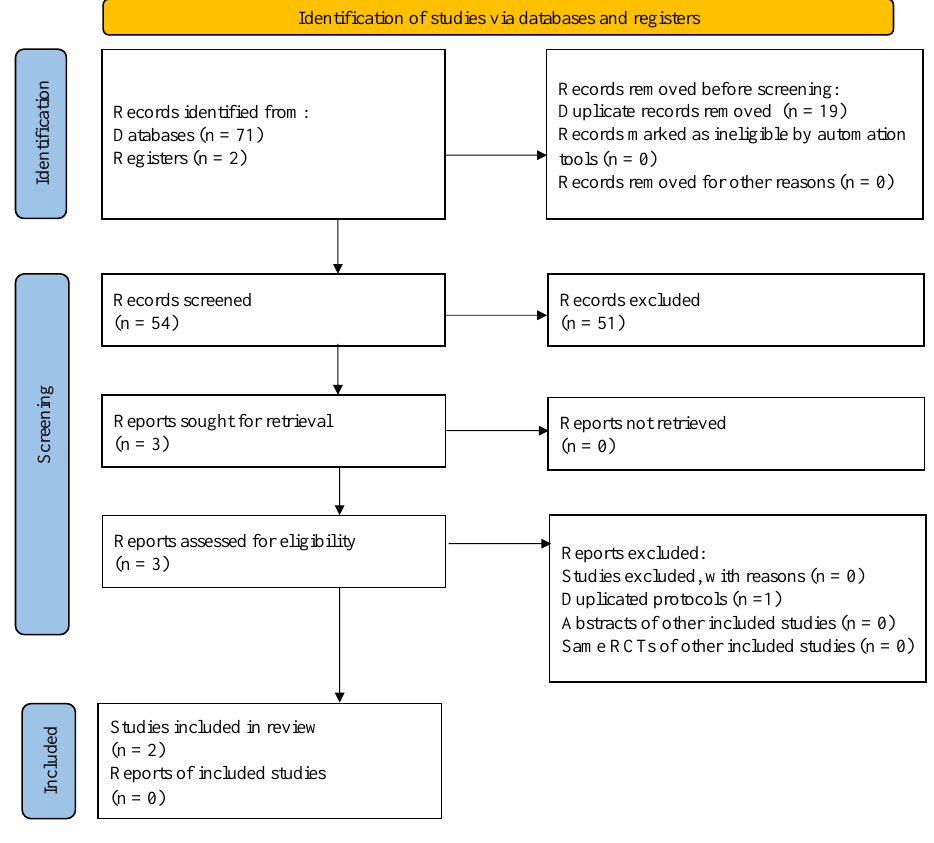
Figure 1. Flow diagram of the literature search results.